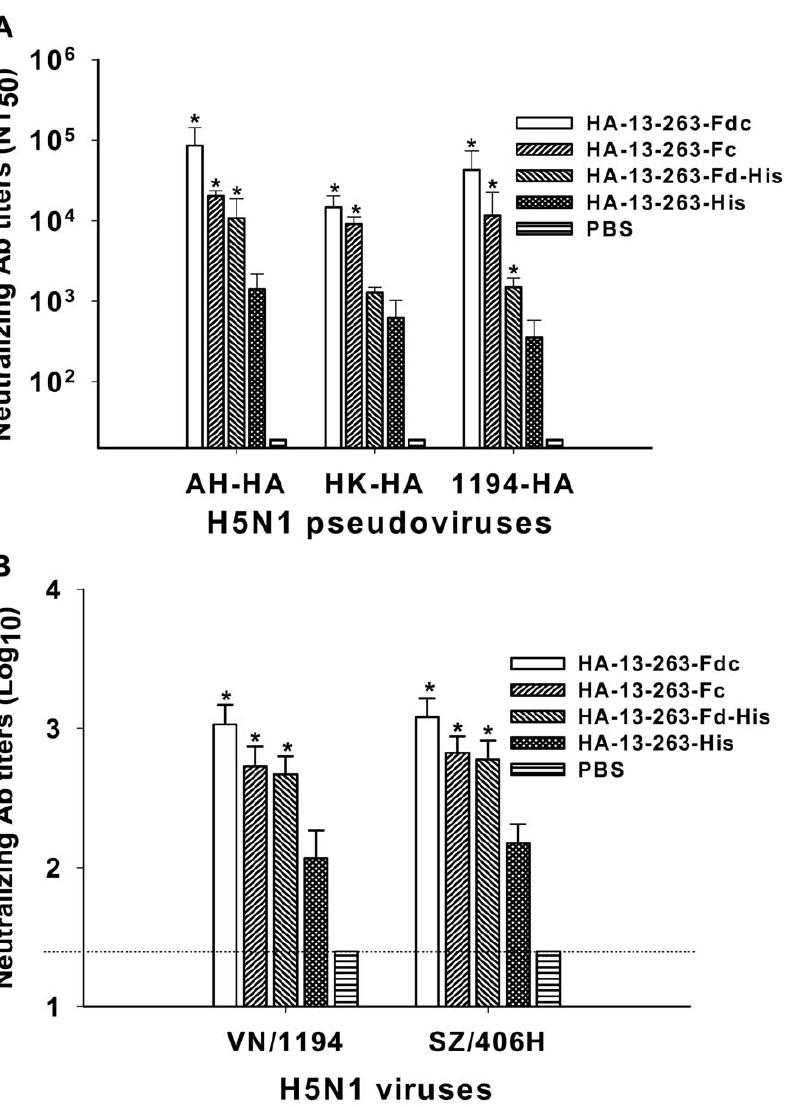
Figure 7. Comparison of neutralizing antibodies in sera of mice vaccinated with HA-13–263 proteins. Sera were collected at 10 days post-last vaccination. PBS was used as the negative control. (A) Neutralizing antibody titers against HA of homologous AH-HA strain (clade 2.3.4) and heterologous A/Hong Kong/156/97 (HK-HA, clade 0) and A/VietNam/1194/2004 (1194-HA, clade 1) strains of H5N1 pseudovirus. The data are presented as mean NT 50 6 SD from five mice per group. * indicates significant difference ( P , 0.05), respectively, between HA-13–263-Fdc, HA-13–263- Fc, or HA-13–263-Fd-His vaccination groups and HA-13–263-His group or PBS control for the three H5N1 pseudoviruses. (B) Neutralizing antibody titers against heterologous strains of A/VietNam/1194/2004 (VN/1194, clade 1) and A/Shenzhen/406H/06 (SZ/406H, clade 2.3.4) H5N1 live viruses. The titers of neutralizing antibodies are presented as mean 6 SD of five mice per group. * indicates significant difference ( P , 0.05), respectively, between HA-13–263-Fdc, HA-13–263-Fc, or HA-13–263-Fd-His vaccination groups and HA-13–263-His group or PBS control for both VN/1194 and SZ/406H viruses. The dotted line shows the limit of detection.